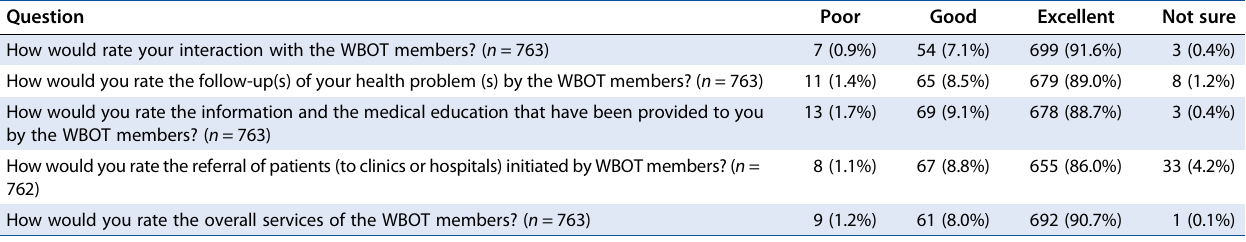
Table 2: Household satisfaction with the services of the ward-based outreach team